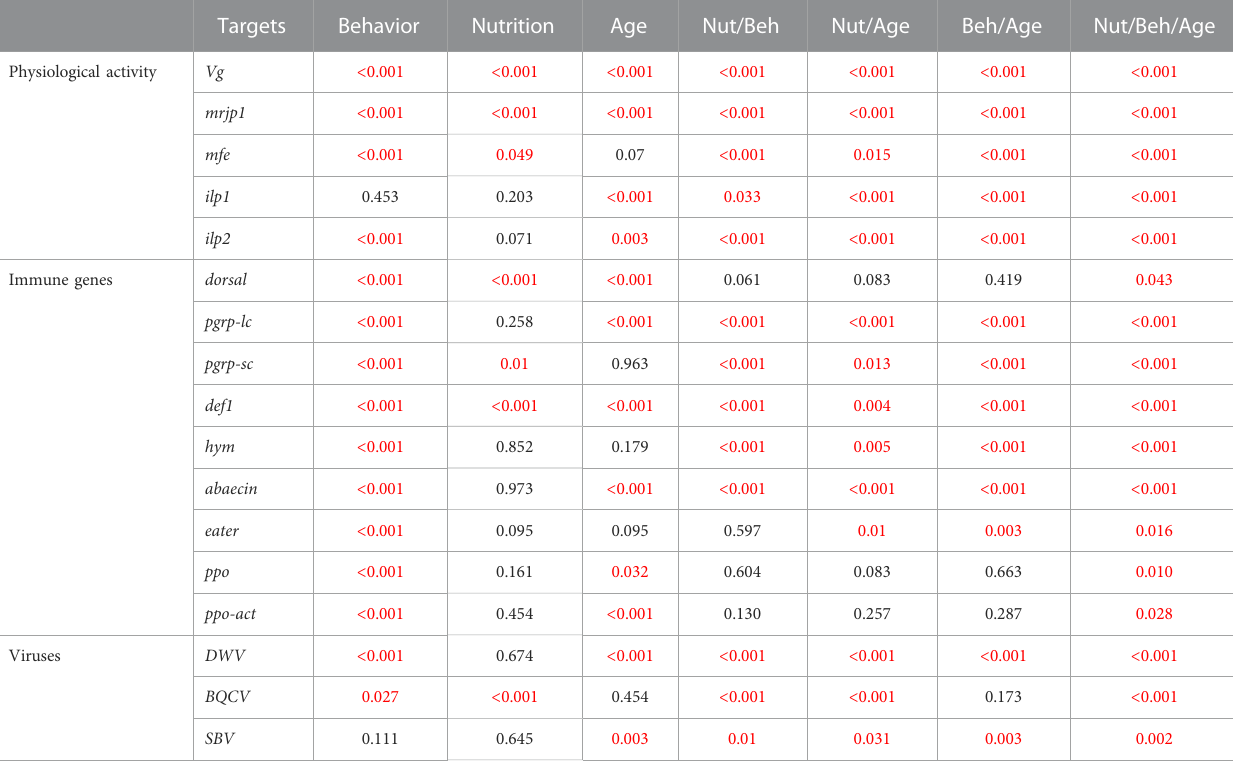
TABLE 1 Probability values of the overall effect of experimental variables on gene expression and viral titers. All the targets were analyzed using the Mann- Whitney test. Signi fi cant p -values are indicated in red case.